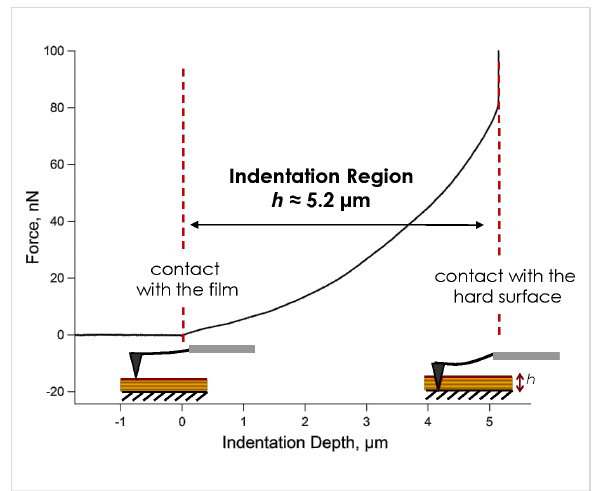
Figure 2: Calculation of the film thickness by the full-indentation method. The dashed lines show the tip-film and tip-substrate contact points. The measurement was made on (PLL/HA) 72 .